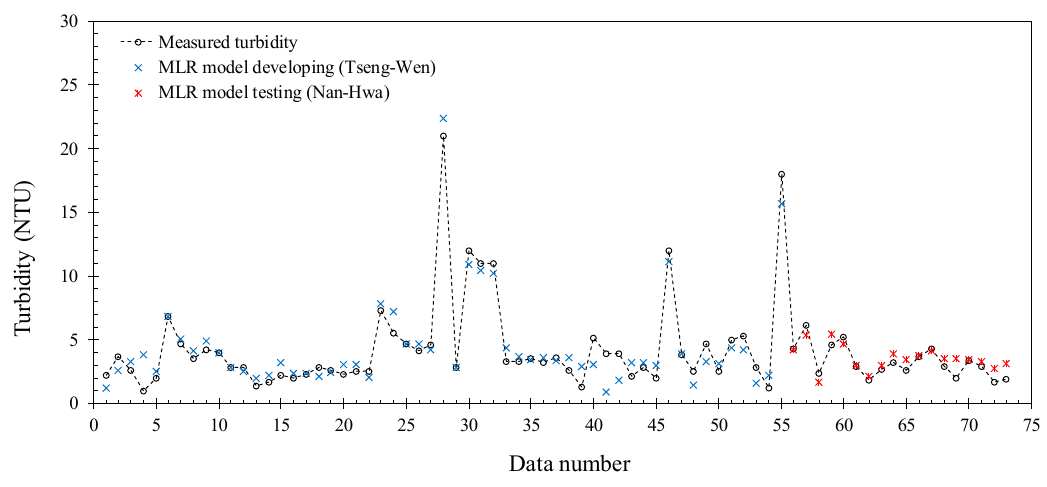
Figure 7. The correlation relationship between observed turbidity and multiple linear regression (MLR) simulated turbidity in Tseng-Wen and Nan-Hwa reservoir. 3.3. Simulated Turbidity by Gene-expression Programming (GEP) Model In the GEP model, the number of chromosomes is 50, the head size is 7, and the number of genes is 4. Only use the essential operation elements including +, − , ×, ÷, 1/x, − x, x, x 2 to avoid building a complicated model, and reduce the number of pattern iteration operations and the number of non- convergence occurrences. Furthermore, based on GEP algorithm, the gene-expression trees were developed and connected to sub gene-expression trees by multiplication. The parameters of the GEP turbidity simulation model are listed in Table 4.